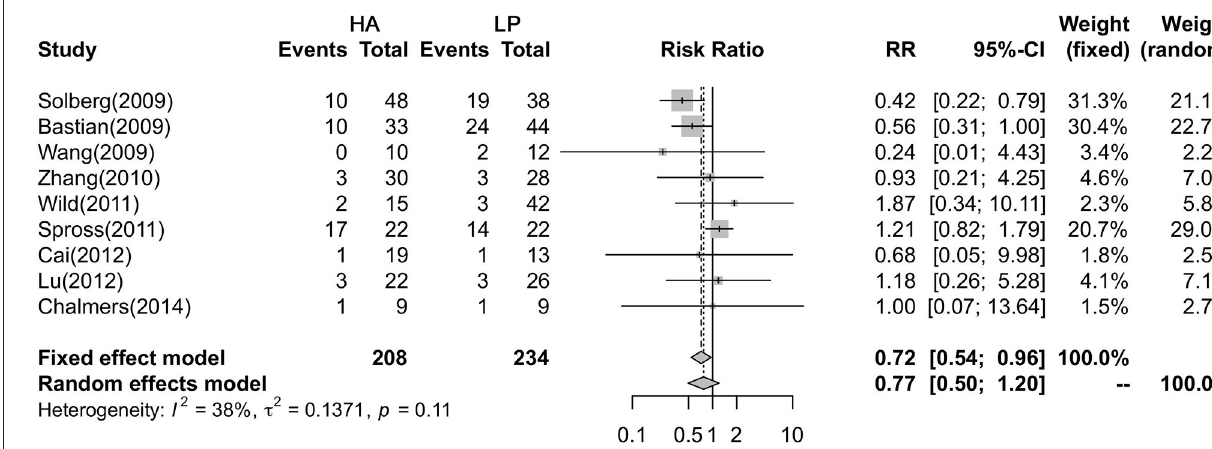
FIGURE 2 | Forest plot showing the meta-analysis of the complications.